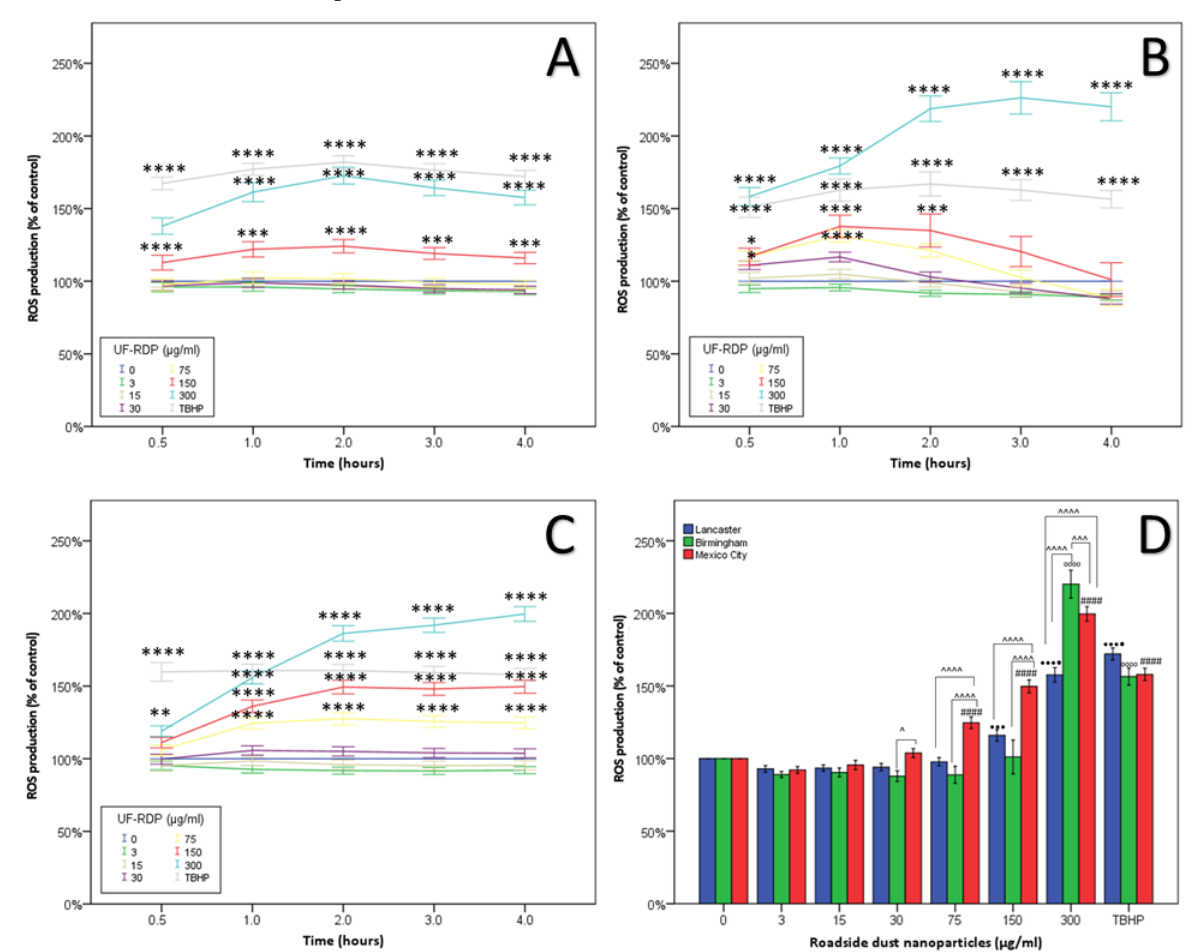
Figure 4. Oxidative stress in Calu-3 cells induced by <220 nm-sized road-deposited dust particles (UF-RDPs). Calu-3 cells were loaded with the ROS probe CM-DCFH-DA and exposed to UF-RDPs (0–300 µg/mL) from Lancaster ( A ) and Birmingham ( B ) (UK) and Mexico City (Mexico) ( C ). Generation of ROS was measured after 0.5 h, 1 h, 2 h, 3 h, and 4 h ( D ) exposure. Tert-butyl hydroperoxide (TBHP) was used at 100 µM as a positive control. A one-way ANOVA with Dunnett’s post hoc was conducted, comparing treated cells to the untreated control (* for A–C and for D: • Lancaster, ₀ Birmingham, # Mexico City) and two-way ANOVA with Bonferroni correction to compare the impacts of the UF-RDPs from the three different locations (^). Statistical significance levels used are: *, p ≤ 0.05; **, p ≤ 0.01; ***, p ≤ 0.001; ****, p ≤ 0.0001 where * may be substituted for ^, #, • or ₀ depending on the city or comparison being made.